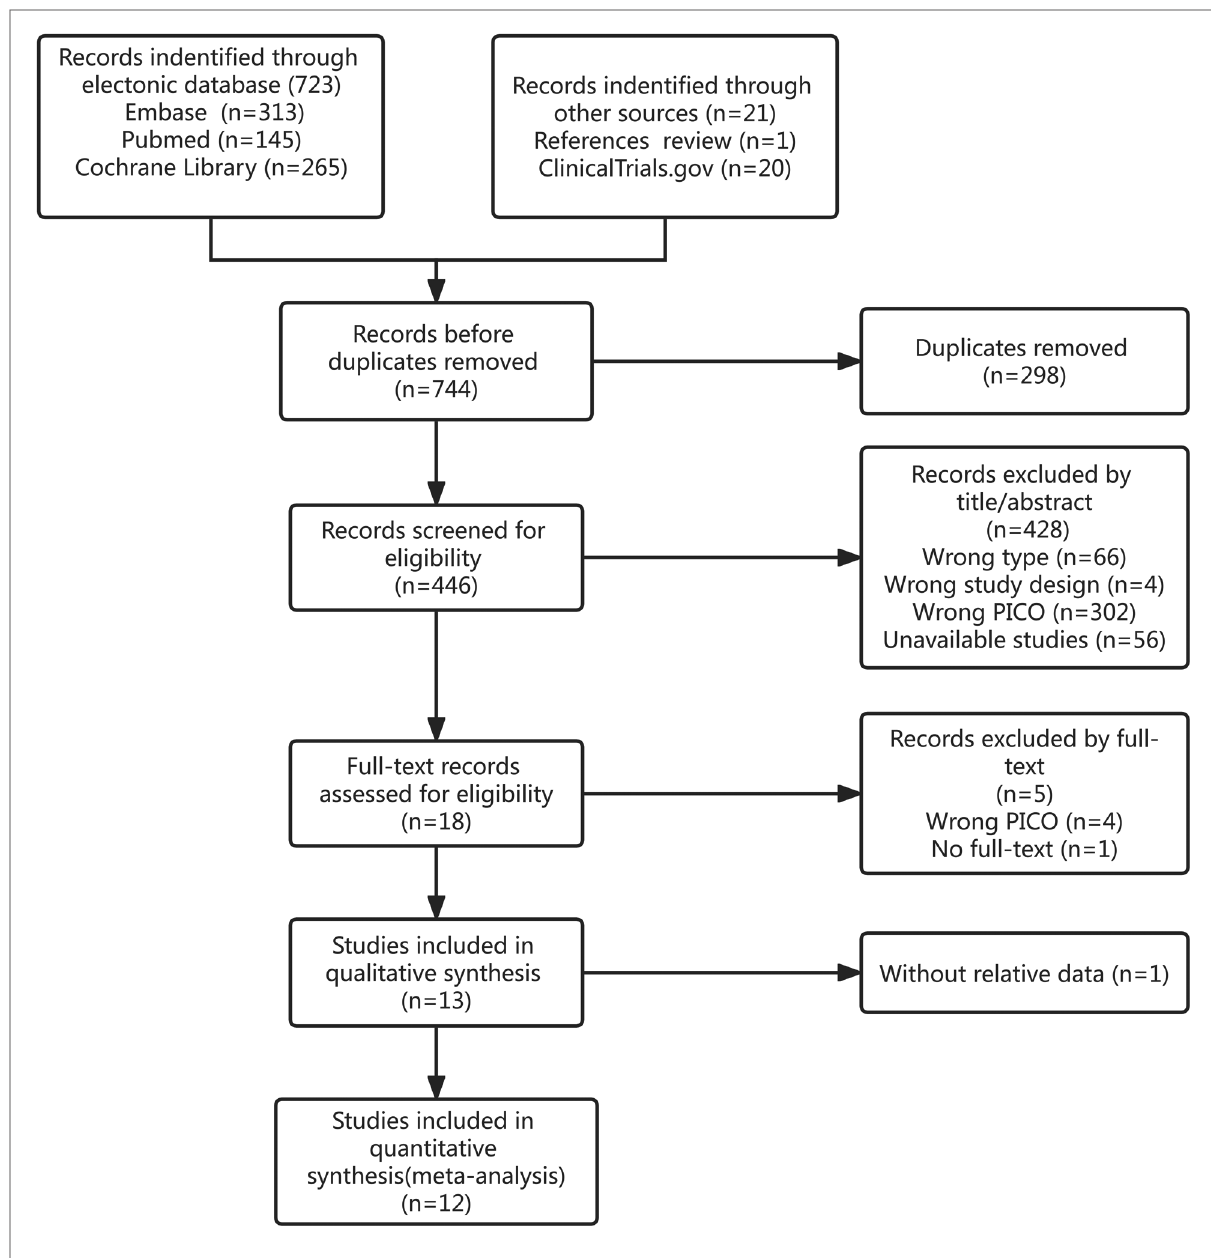
FIGURE 1 The fl ow diagram about the study retrieval